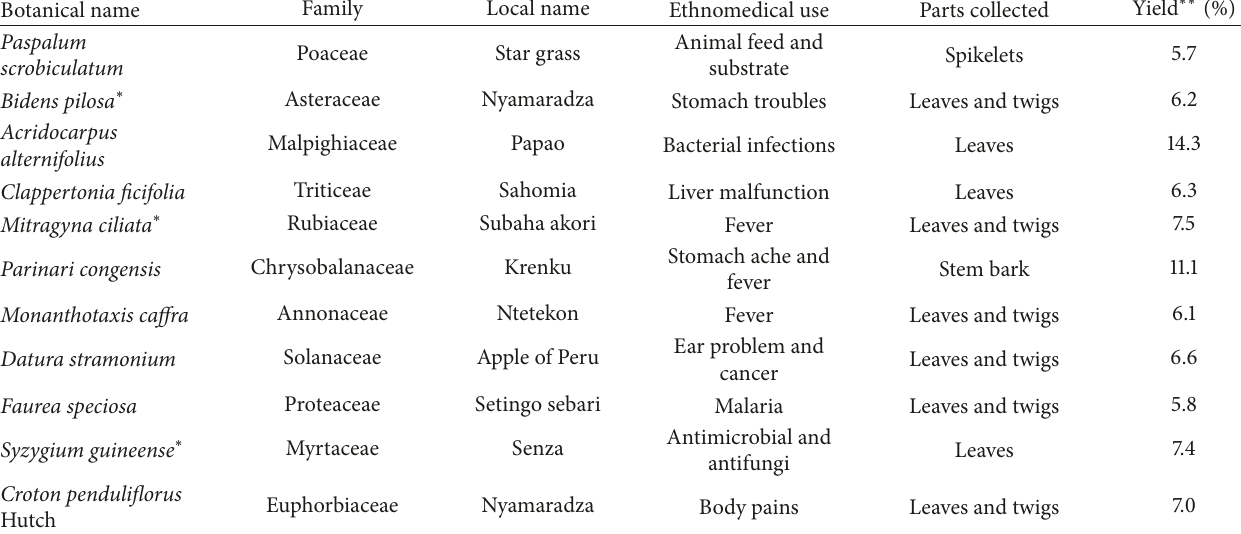
Table 1: Plants selected for the study and their traditional